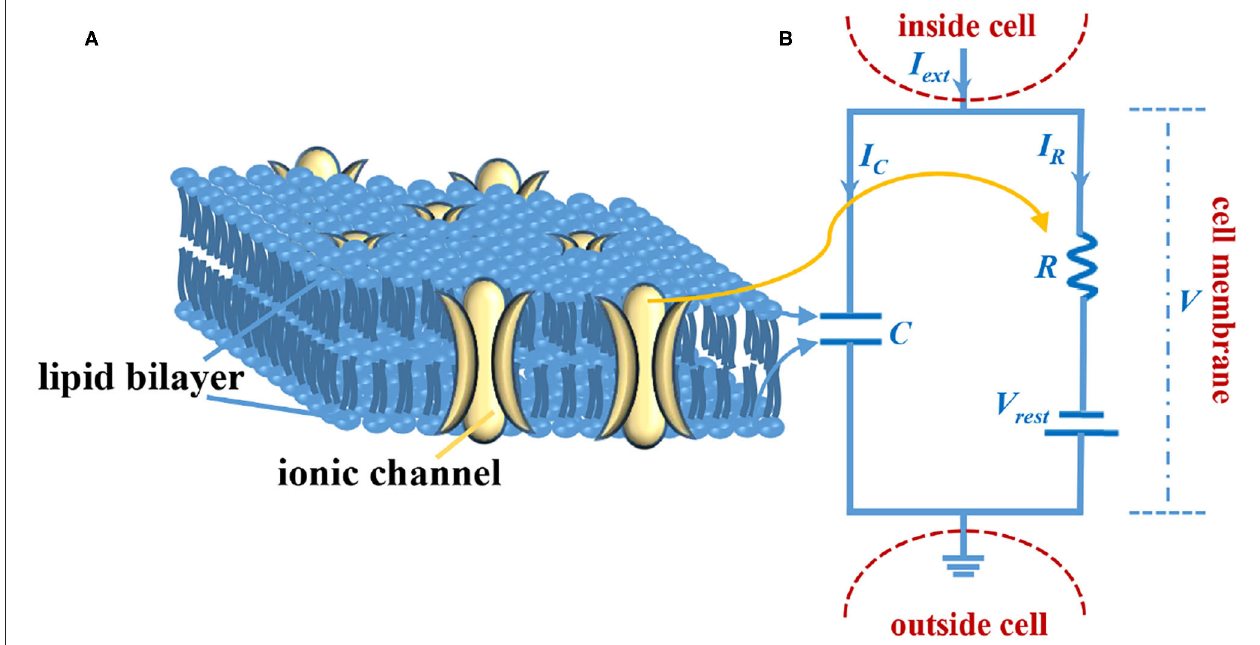
FIGURE 1 | The LIF circuit model of the axon membrane. (A) The sketch of the cell membrane. (B) The circuit model of the cell membrane.